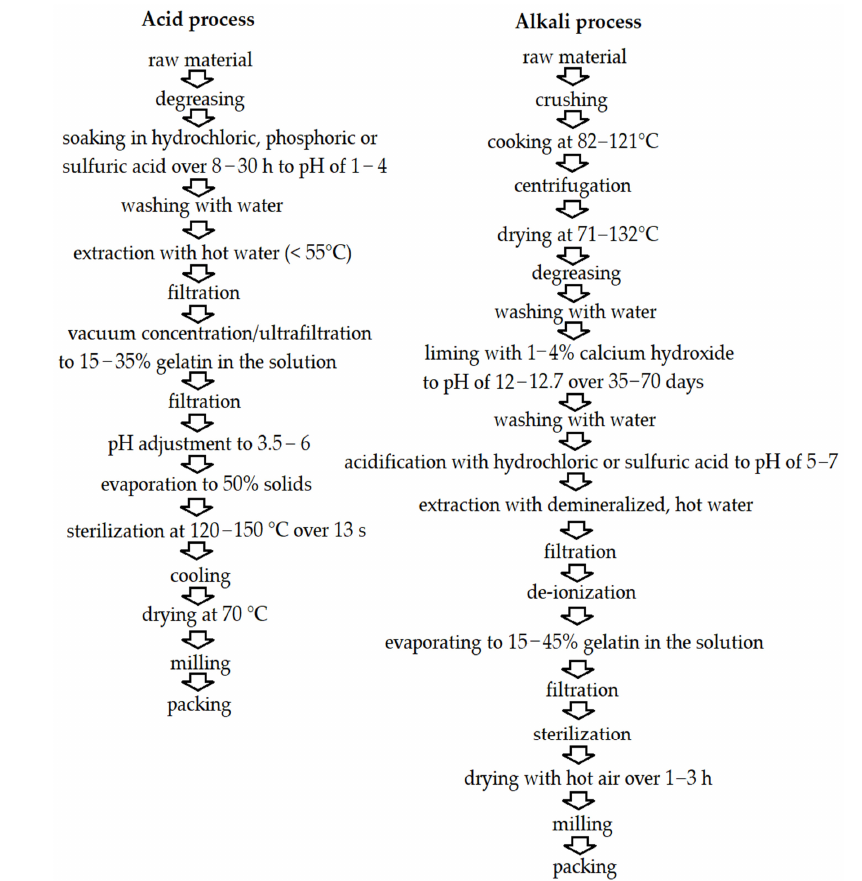
Figure 5. Flow diagram of acid and alkali process of gelatin production. Own figure based on Ref. [146]. 2022, Wasswa et al.